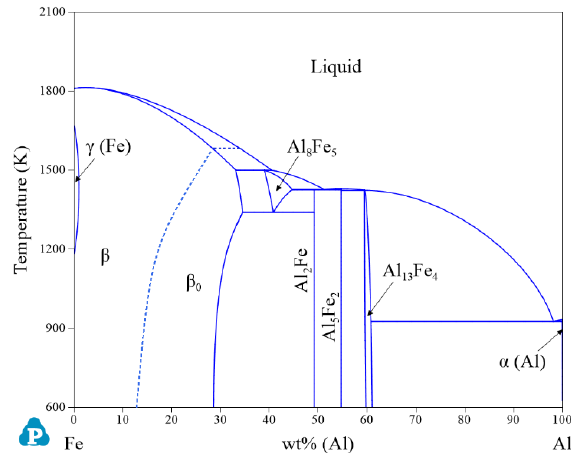
Figure 3. Calculated Ti-V phase diagram using the thermodynamic parameters obtained by Ghosh et al. [27].